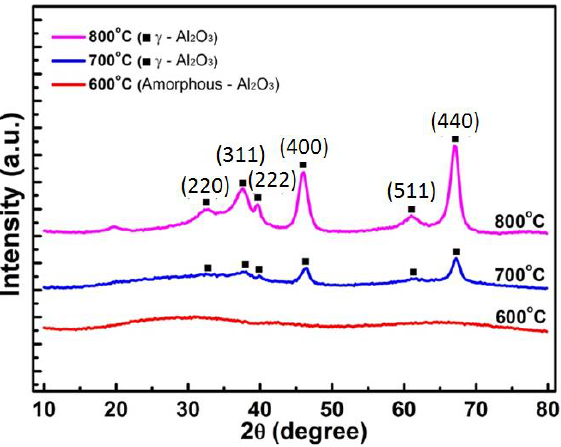
Figure 7. X-ray diffraction peaks of alumina fibers calcined at 600 °C, 700 °C, and 800 °C.